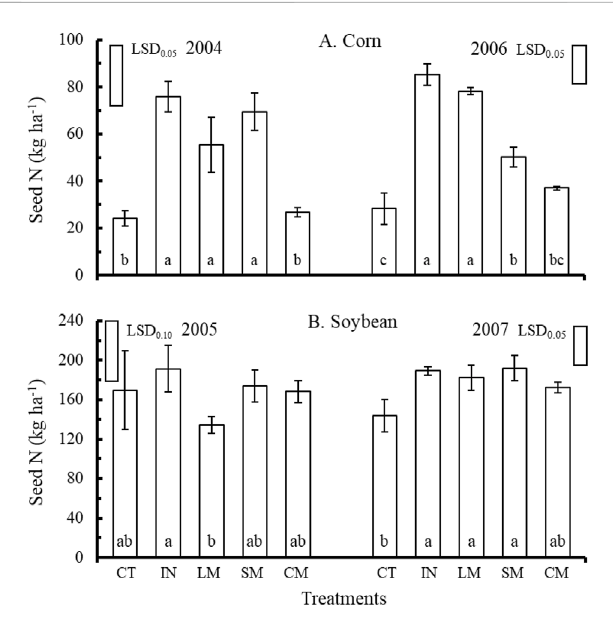
FIGURE 2 Grain N removal (seed N) of corn and soybeans in rotation from 2004 to 2007. The abbreviations of CT, IN, LM, SM, and CM referred to the control without fertilization, inorganic fertilizer, liquid swine manure, solid swine manure, and composed swine manure, respectively. There was no signi fi cant difference between the bars labeled with the same letter on it within the same year under Fisher ’ s protected LSD test at a signi fi cant level of p ≤